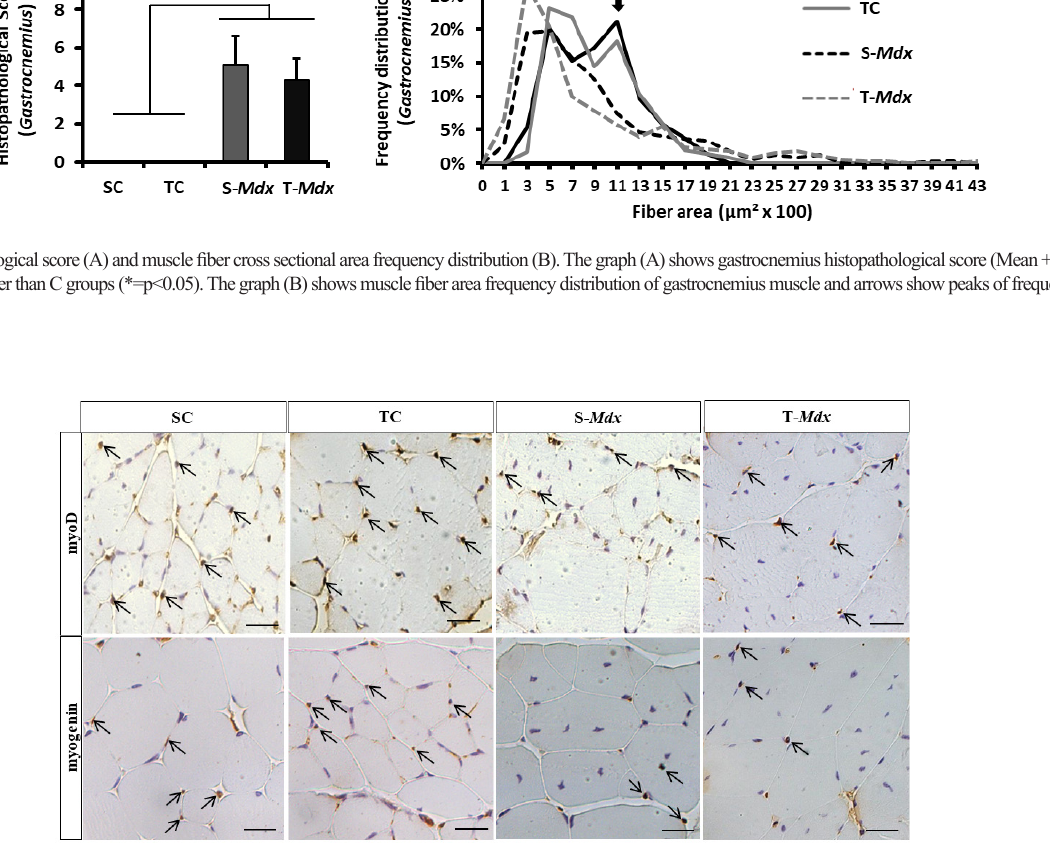
Figure - 3 Effects of exercise on both myoD and myogenin immunoexpression of gastrocnemius muscle. Thin arrows highlight nuclear immunoexpression. Bar = 50μm.